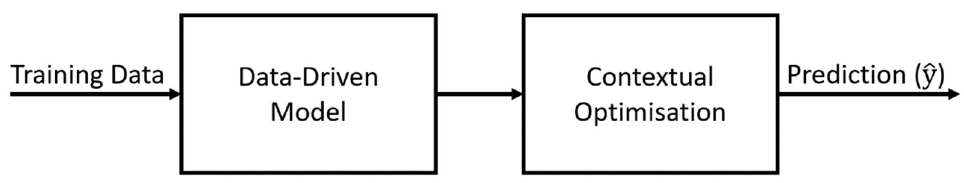
Figure 3. BlockdiagramofDCF,showingitstwomainparts: Figure 3. Block diagram of DCF, showing its two main parts: data-driven model and contextual optimisation.